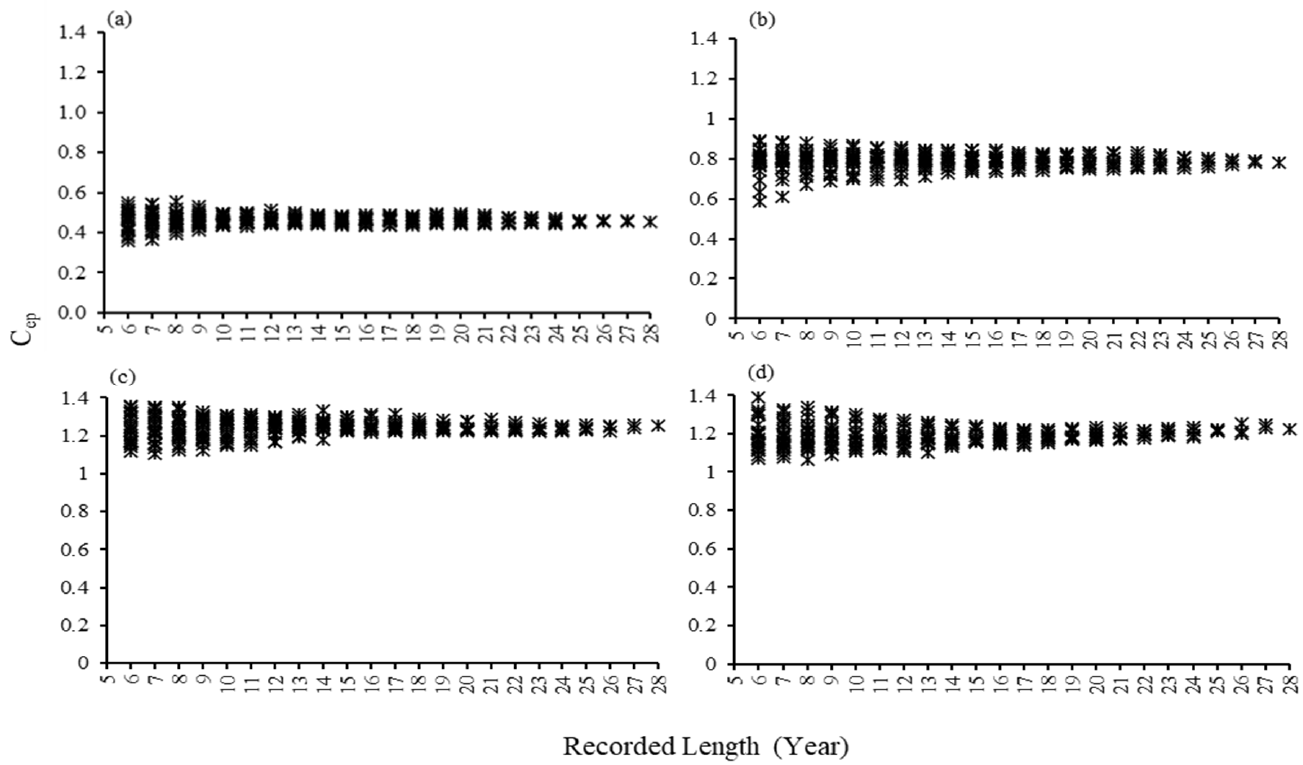
Figure 1. The values of Cep for ( a ) Doki River Basin ( b ) MOPEX ID 3504000 ( c ) MOPEX ID 2387500 and ( d ) MOPEX ID 2448000.